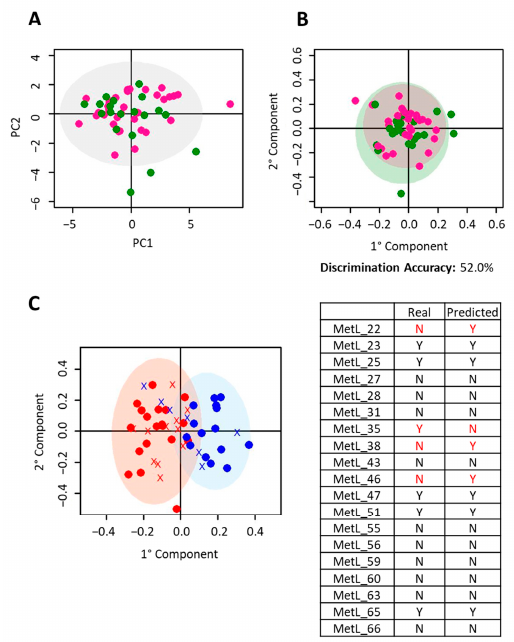
Figure 3. Prediction of Pembrolizumab subjects. Discrimination between the metabolomic profiles of baseline serum samples (T0) from nivolumab- and pembrolizumab- treated subjects. Score plots of ( A ) PCA analysis; ( B ) O-PLS analysis. In each score plot, each dot represents a different serum sample. Purple dots: nivolumab; green dots: pembrolizumab. ( C ) Prediction of pembrolizumab-treated subjects. O-PLS analysis of T0 serum samples. Score plot, PC1 vs. PC2, and corresponding confusion matrix. Red dots: nivolumab responder subjects; blues dots: nivolumab non-responder subjects. Red crosses: pembrolizumab subjects predicted as non-responders; blue crosses: pembrolizumab subjects predicted as responders.